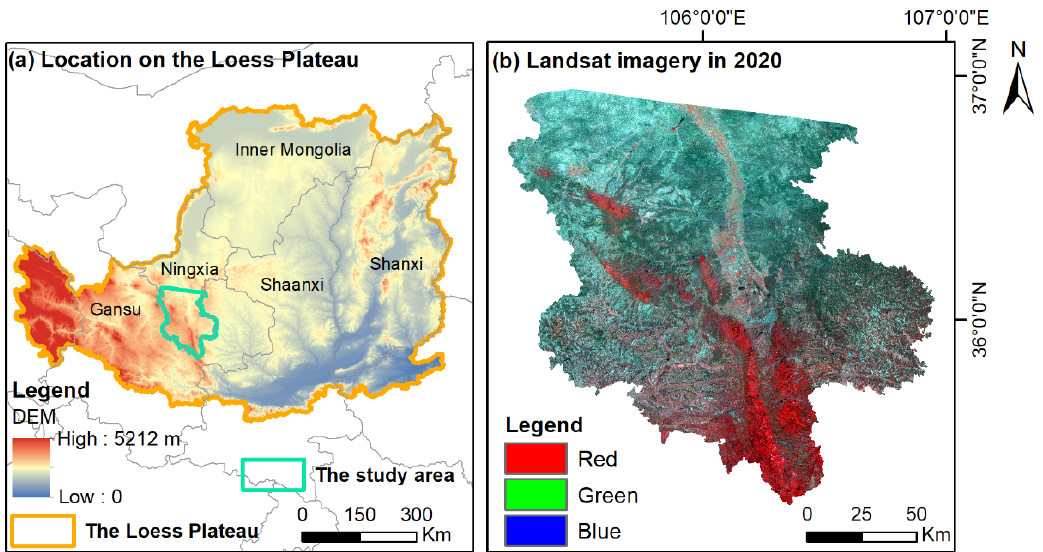
Figure 2. Location of the study area on the Loess Plateau based on a digital elevation model (DEM) ( a ), and ( b ) annual composite Landsat imagery (red–green–blue bands) based on the median reflectance in 2020.